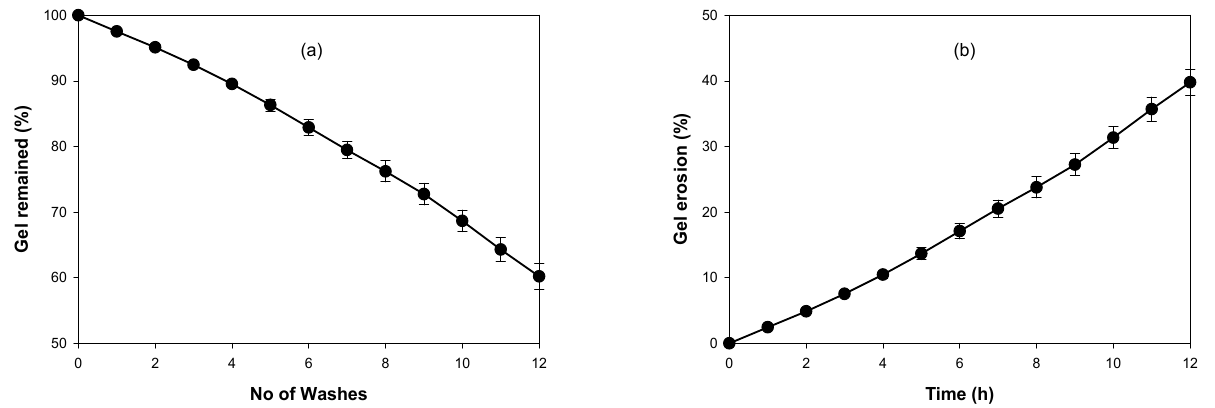
Figure 7. ( a ) Washability and ( b ) gel erosion profile of TBN-CSNP loaded P407 gel in phosphate buffer pH 5.5. (Each value represent mean ± S.D ( n = 3).